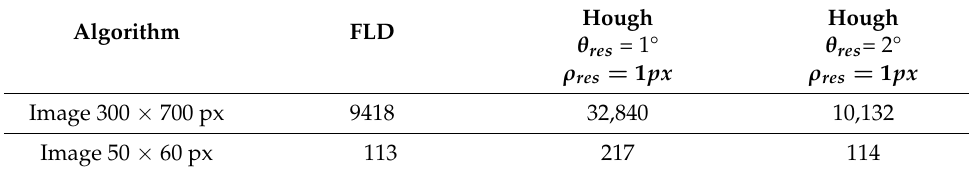
Table 3. Time efficiency comparison of the Hough and fast line detection algorithms in OpenCV, in µ s